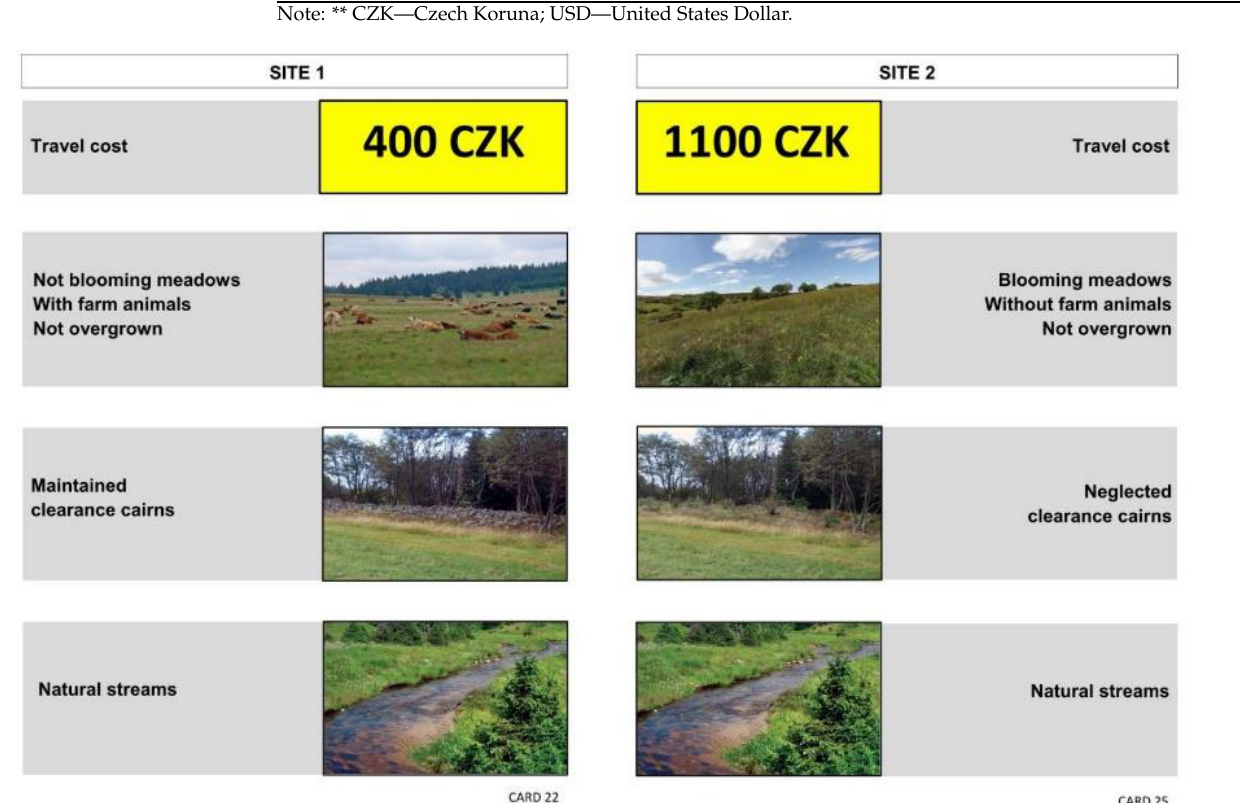
Figure 2. Example of the choice set (source: authors).